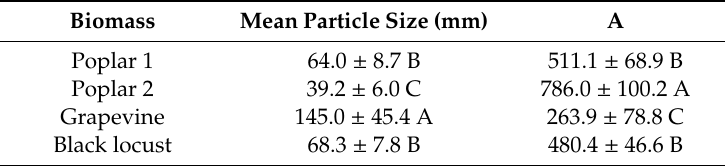
Table 2. Mean particle size and resistance to air flow (mean ± SD) before drying. For each column, di ff erent letters indicate a significant di ff erence at the level of P ≤ 0.01 after Tuckey’s HSD